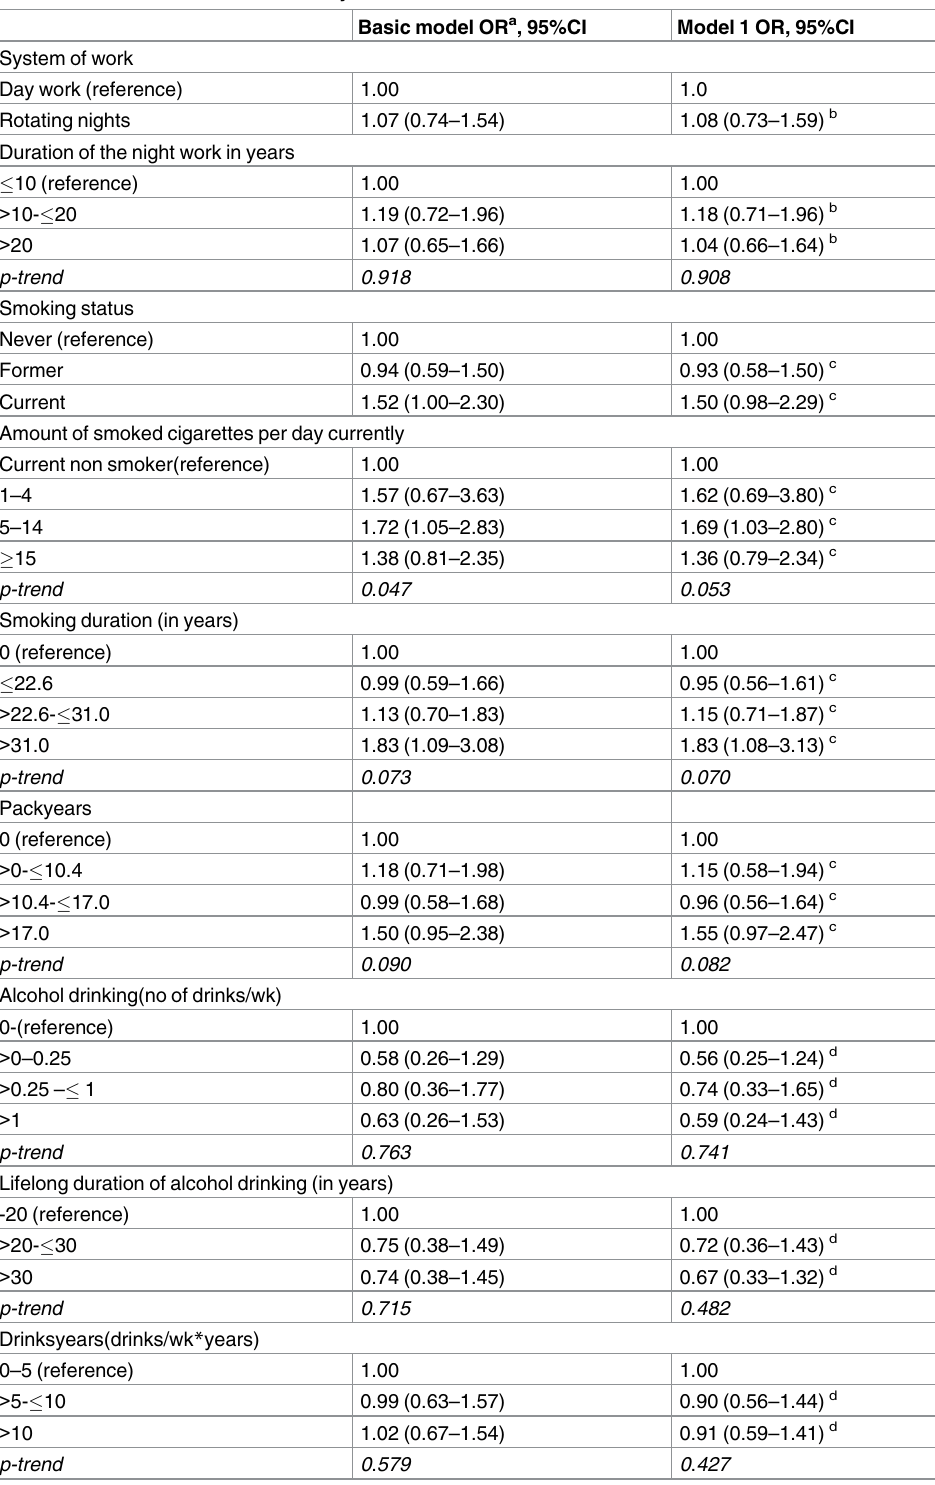
Table 2. The association between methylation of BRCA1 gene and lifestyle factors among nurses and midwives in the cross-sectional